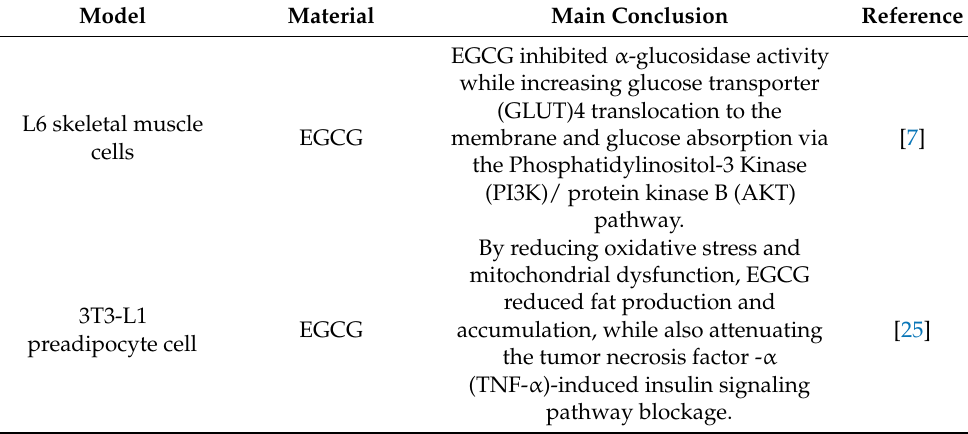
Table 1. Improvement of diabetes through